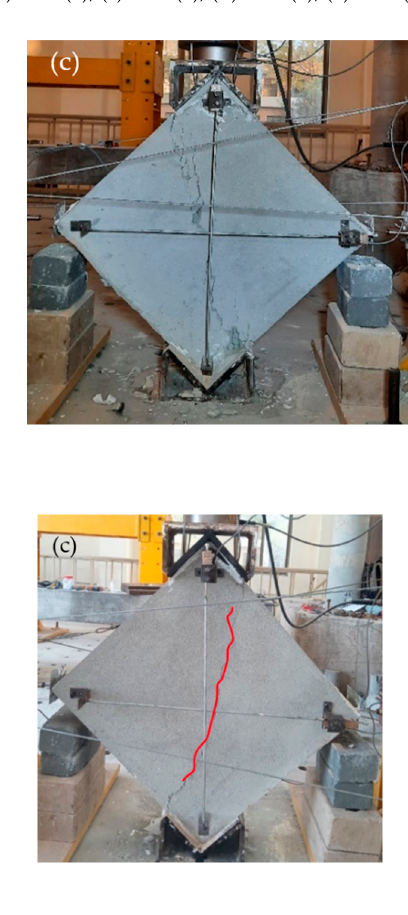
Figure 10. Failure patterns of PB reinforced wallets.